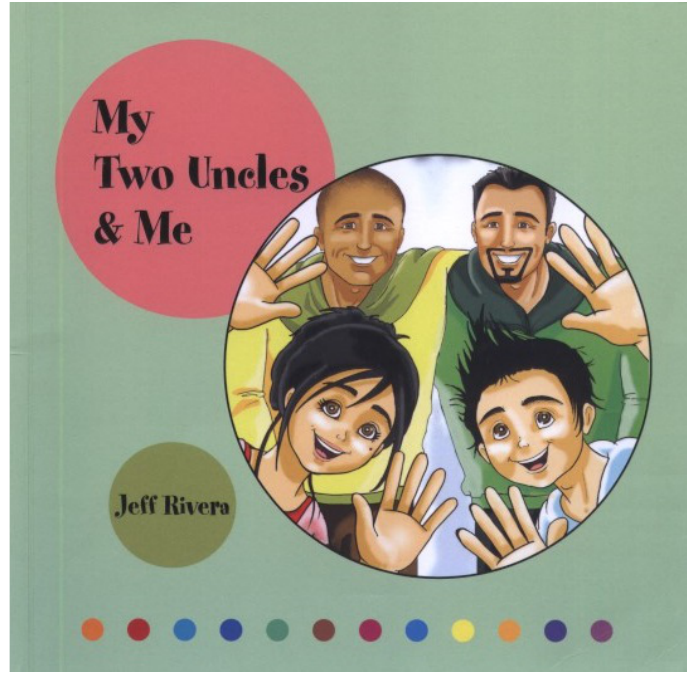
Figure 7. Jeff River’s picture book offers an intimate snapshot of queer interracial family life.